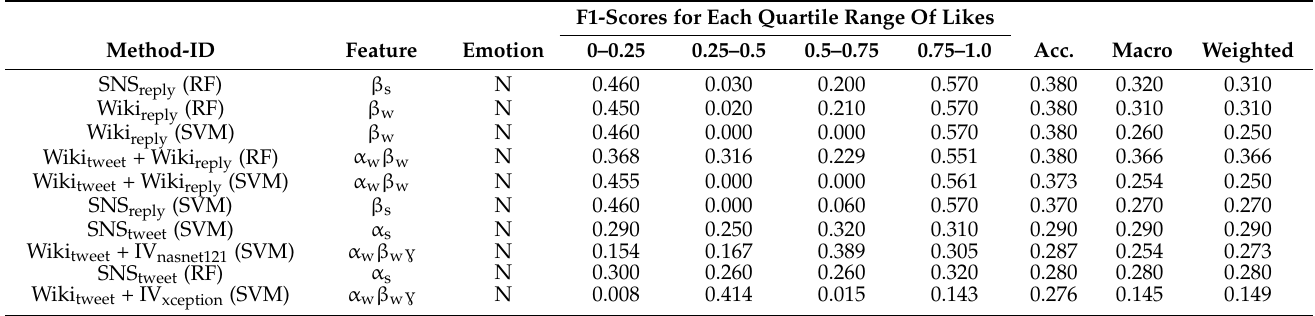
Table 6. Top 10 F1-scores and accuracies of like prediction (baseline methods). F1-Scores for Each Quartile Range Of